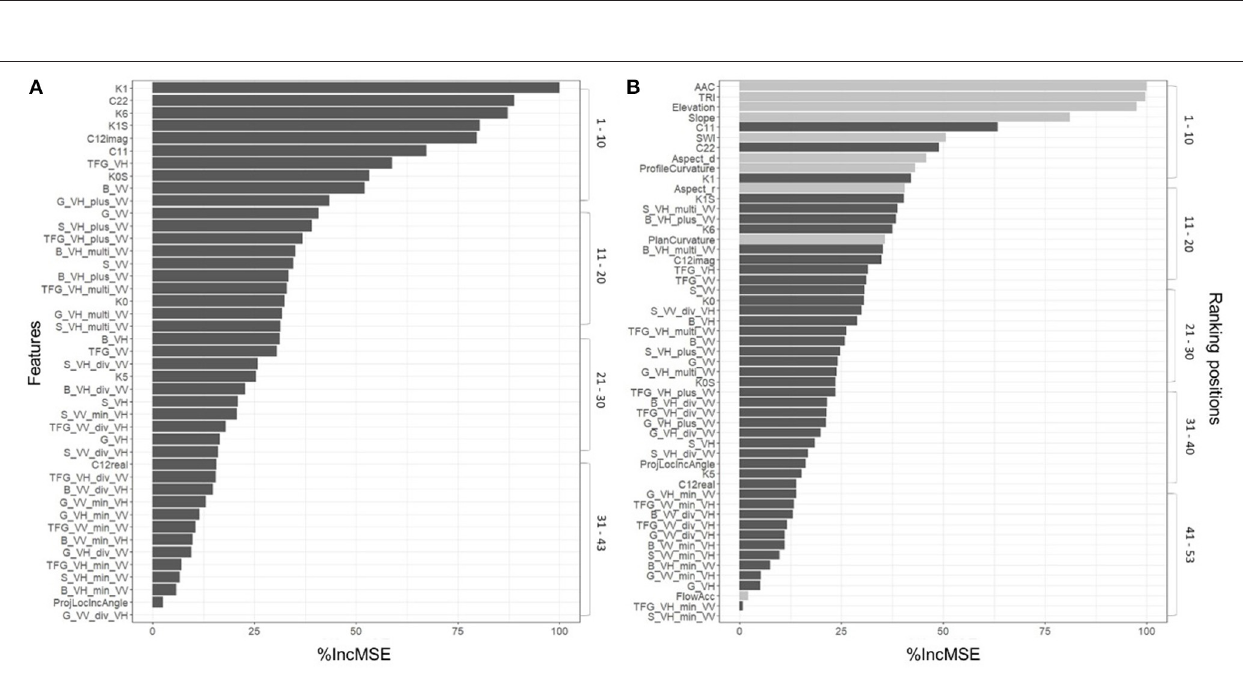
Frontiers in Water |